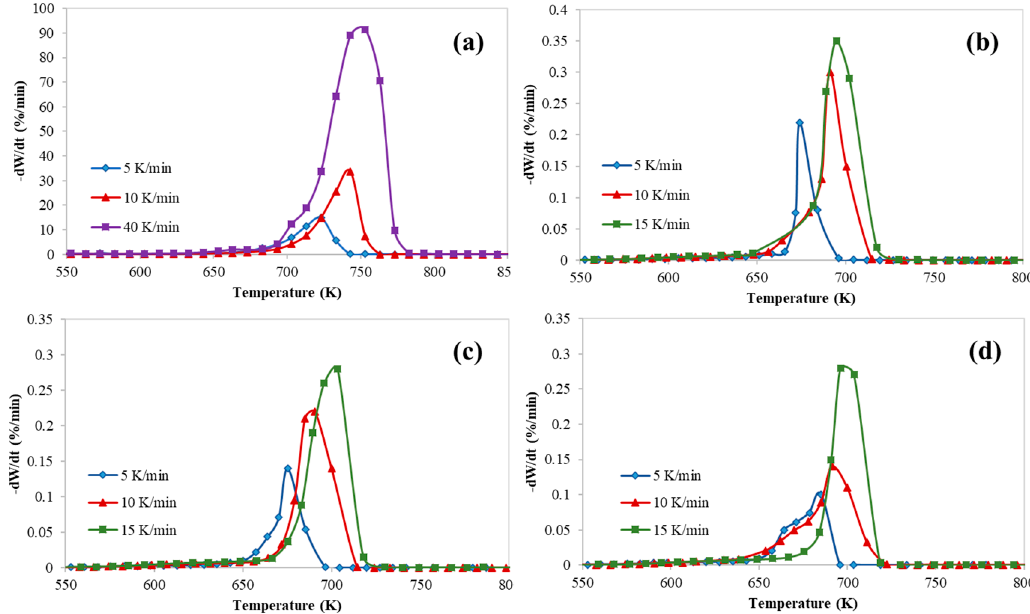
Figure 2. Derivative thermogravimetric (DTG) thermograms of catalytic pyrolysis of HDPE at different catalyst to polymer mass ratio: ( a ) 0, ( b ) 0.5, ( c ) 0.77, and ( d ) 1 .